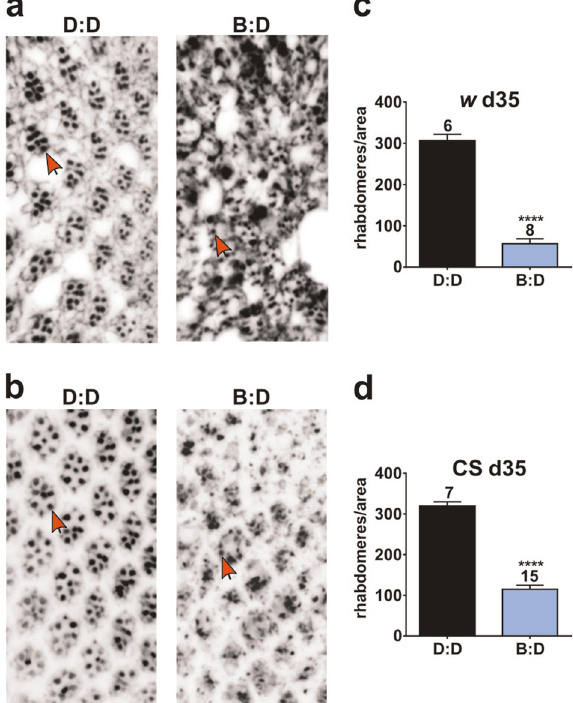
Fig. 3 Retinal photoreceptors degenerate under blue light in fl ies with white or red eyes. Representative retinal cross sections of 35-day- old w a and CS b males in D:D and B:D. Red arrows point to identi fi able rhabdomeres. c , d The average number of rhabdomeres is signi fi cantly reduced in 35-day-old w and CS males in B:D compared with D:D (unpaired t test, **** p < 0.0001). Numbers above bars indicate the sample size in each light condition. Error bars show SEM